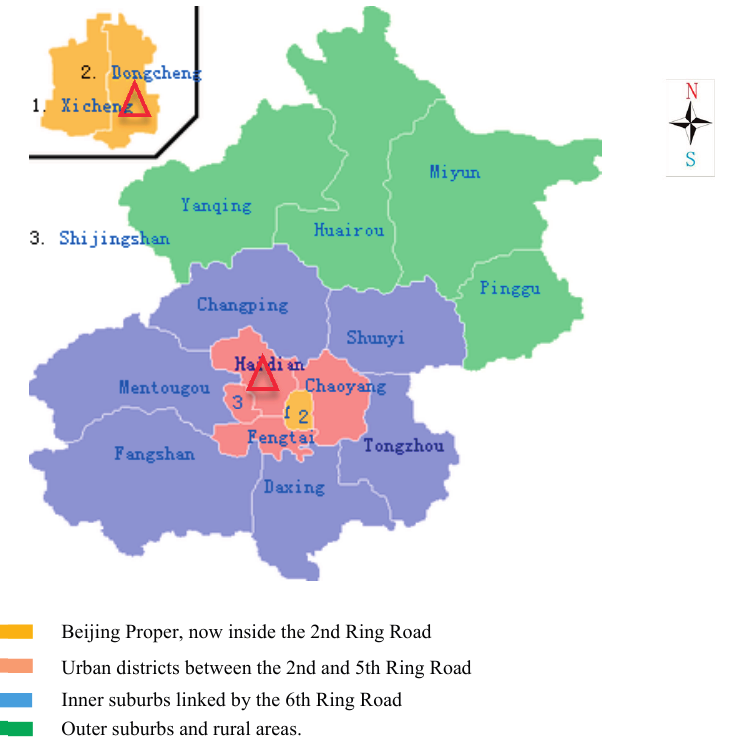
Figure 2. Map of Beijing and survey area (source: Google